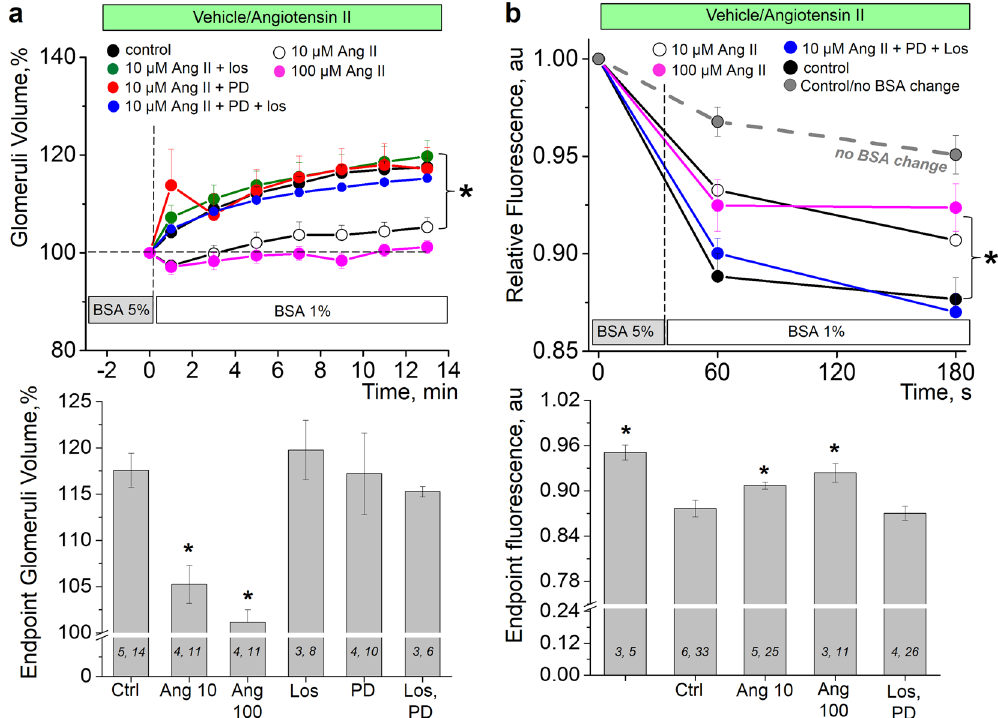
Figure 2. Effects of ATR blockers on rat glomeruli permeability and volume changes. ( a ) Activation of AT receptors by 10 or 100 µ M of Ang II significantly suppresses glomeruli ability to respond to oncotic gradient changes evoked by solution change from 5% to 1% BSA (black, white and magenta data points represent control (vehicle), and 10 or 100 µ M of Ang II, respectively). Inhibition of either AT 1 or AT 2 receptors with 10 µ M losartan or 1 µ M PD 123319, respectively (green and red data points) or both antagonists together (blue data points) restores normal glomeruli function and attenuates permeability. Summary graph for the endpoint glomeruli volume is shown on the lower panel. ( b ) Pre-application of Ang II significantly inhibits changes in glomerular FITC fluorescence and corresponding water flux across the capillary wall in response to changes in oncotic gradient. Application of ATRs blockers restores normal renal hemodynamics and attenuates glomerular permeability to protein. Summary graph for the endpoint glomeruli fluorescence is shown on the lower panel. ( i , j ) noted on graph is number of animals ( i ) and glomeruli ( j ) analyzed in each group, respectively. * P < 0.05 versus control